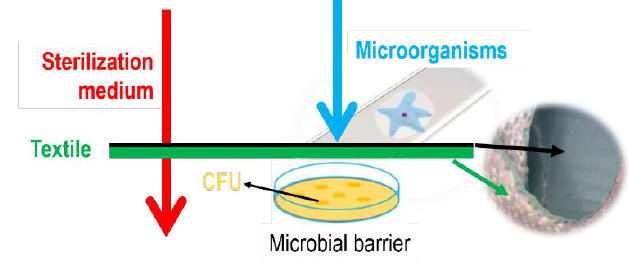
Figure 2. Microbial barrier.